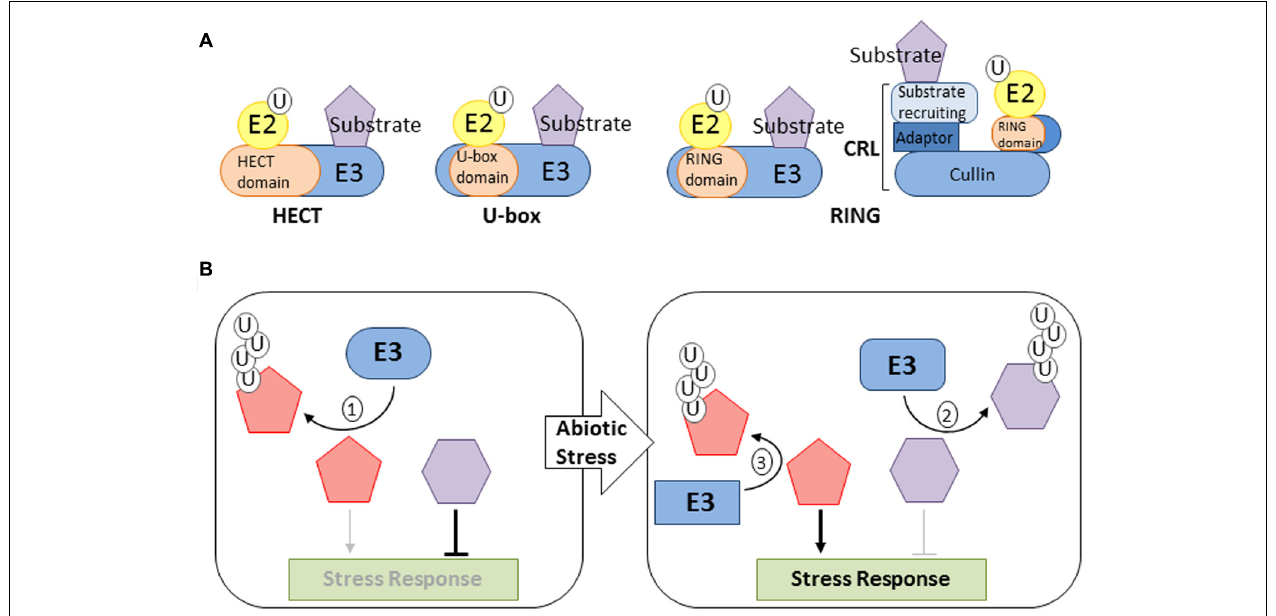
common modes of action for E3 ligases in regulating abiotic stress responses. (1) E3 ligases may function as a negative response regulators required to supress stress response pathways by targeting positive regulators for degradation. (2) E3 ligases may promote stress signaling by functioning as positive response regulators that target negative regulators for degradation following stress perception. (3) E3 ligases may also function to attenuate stress signaling by targeting positive regulators for